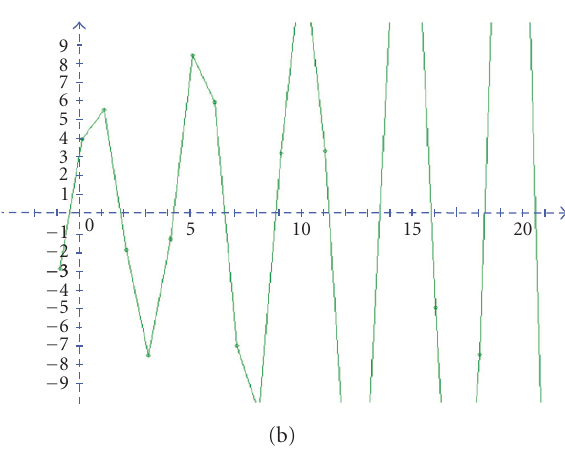
Figure 3.11. (a) Behavior of y n in the point R ; (a) behavior of x n in the point R